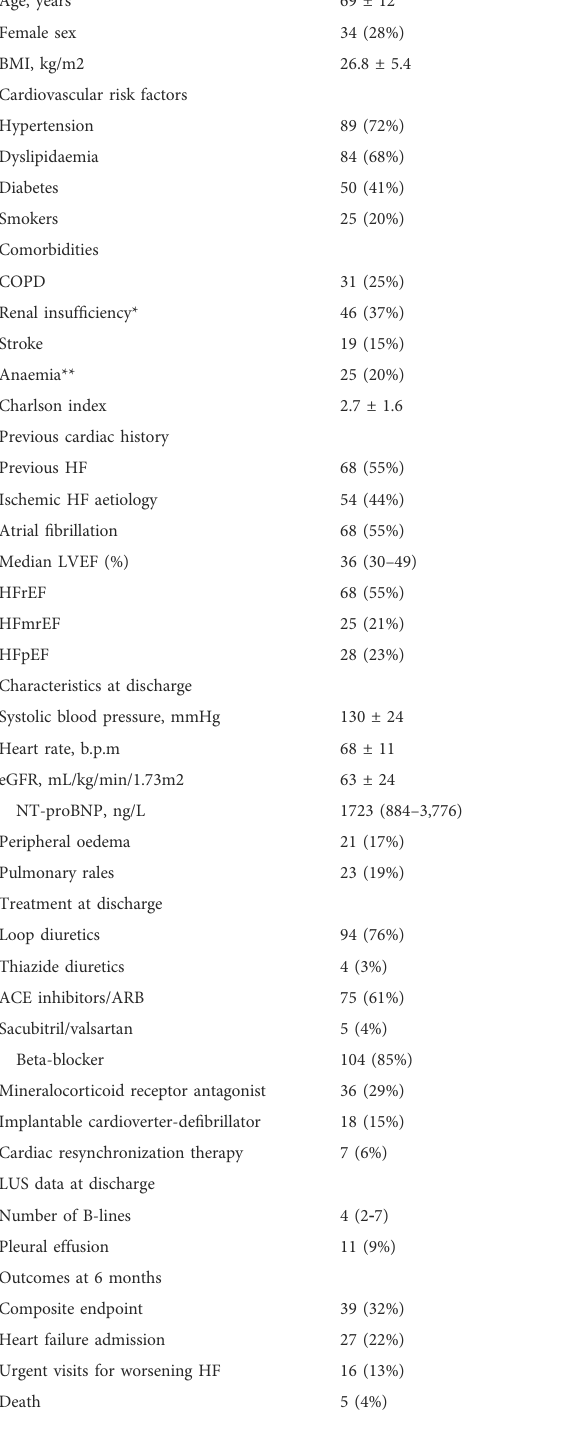
TABLE 1 Baseline characteristics of the study